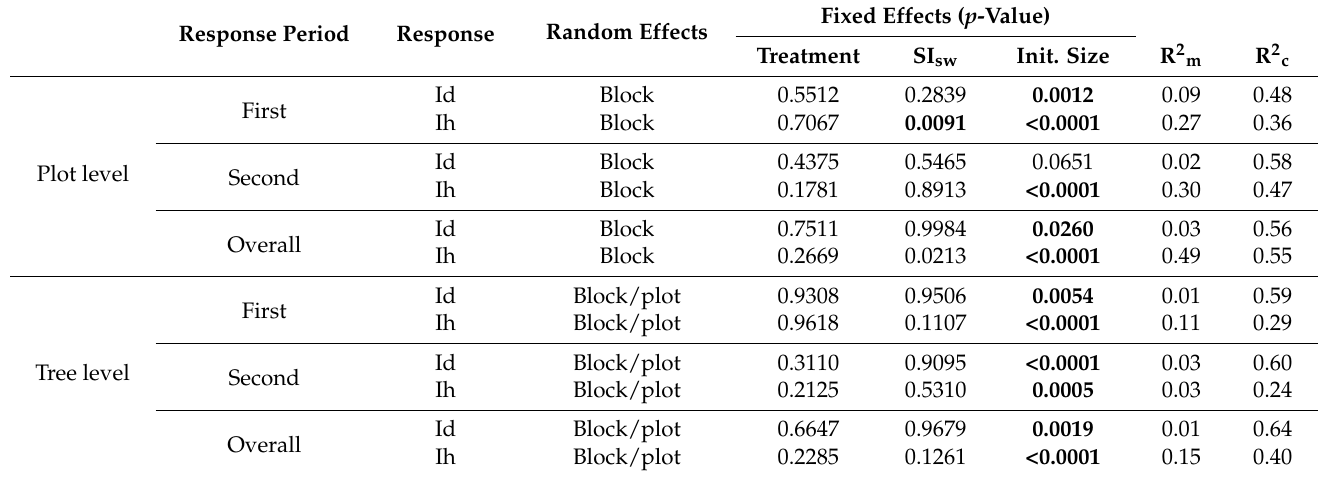
Table 4. Results from linear mixed-effect models for diameter and height increment of white spruce by measurement period. R 2 m is marginal coefficient of determination; R 2 c is the conditional coefficient of determination. Id is diameter increment, Ih is height increment. Bold numbers indicate a statistically significant difference ( p -value less than